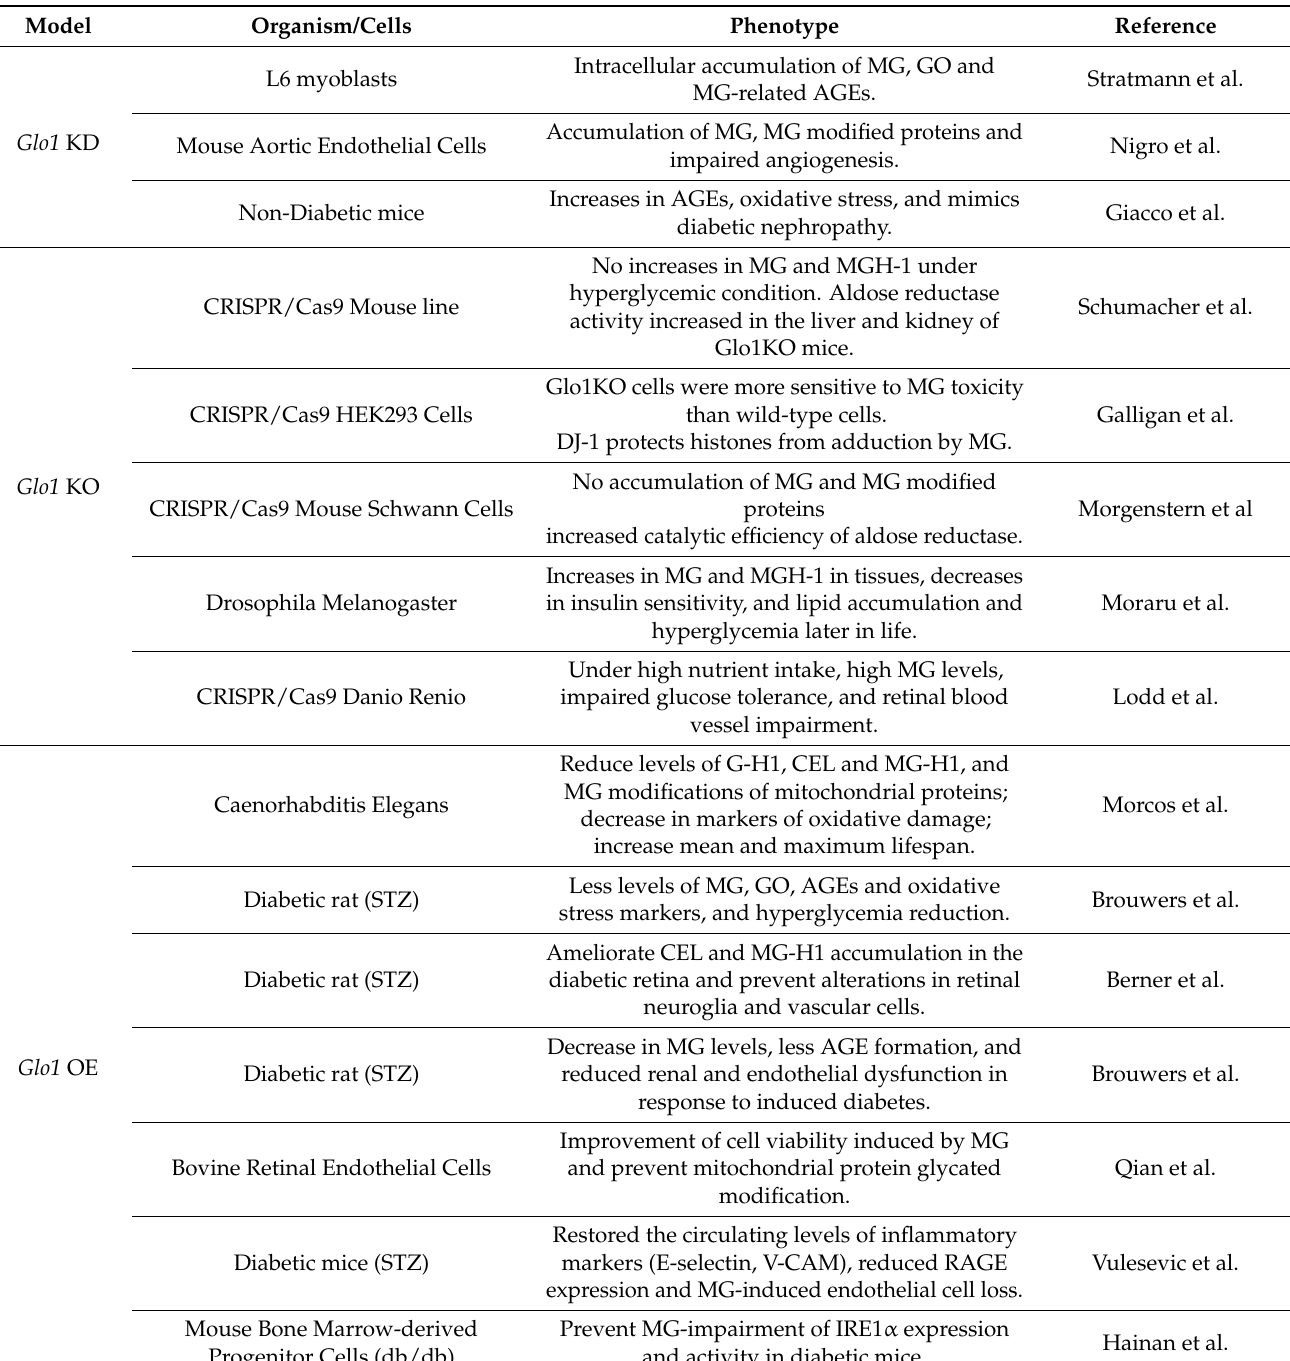
Table 1. Summary of relevant studies related to the glyoxalase 1 modulation in research on diabetes and aging.